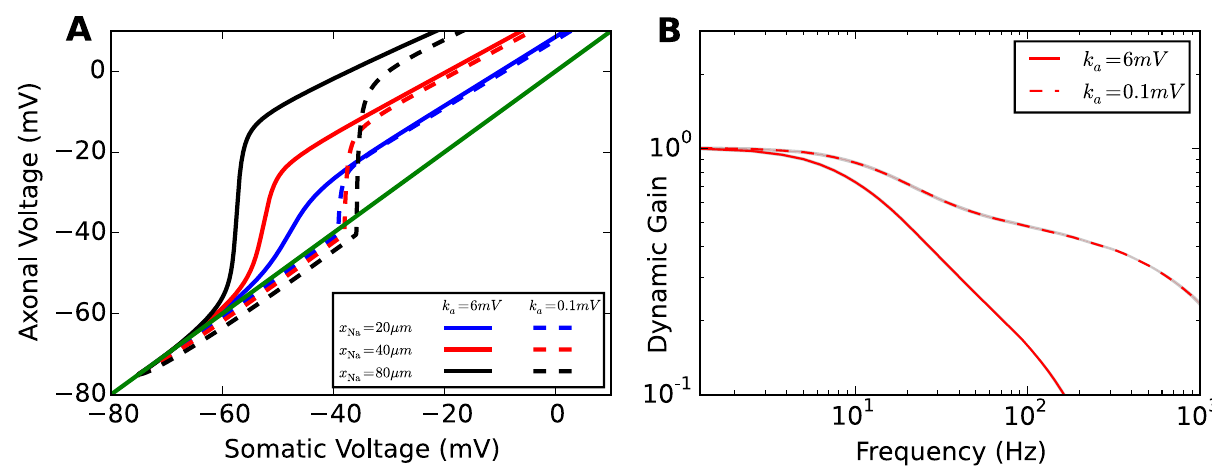
Fig 7. Impact of voltage sensitivity of sodium current activation curve on voltage decoupling under current clamp and dynamic gain. A Plot of axonal voltage at x Na vs. somatic voltage for different sodium channel positions. Solid lines are voltage traces for low voltage sensitivity k dashed lines denote the traces for high voltage sensitivity k a = 0.1mV. B Dynamic gain functions for the different voltage sensitivities for x Na = 40 μ m = 1mV and longer correlation times can be found in S3 Fig. and τ = 5ms. The dynamic gain curve for the intermediate value k a